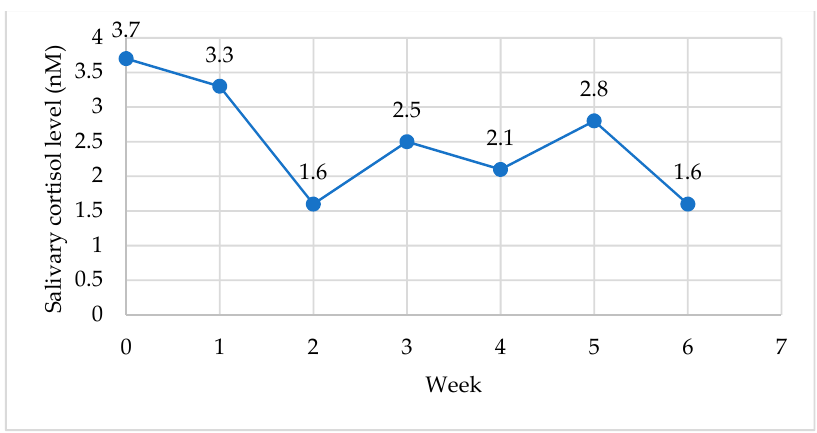
Figure 4. Resting salivary cortisol levels from baseline to week six of the program ( n = 17). Paired-Sample t -Tests Pre- and Post-Program A Shapiro–Wilk test showed the probability of normality for the CAR (waking) dataset, W (17)= 0.93, p = 0.30, and resting dataset, W(17) = 0.97, p = 0.91; therefore, normality was assumed ( p > 0.05). Paired sample t -tests were completed to compare the measure scores pre- (week 0) and post-program (week 6) and pre- and post-session for weeks 4 to 6. A summary of the paired sample t -test analysis is provided in Table 6. Table 6. Paired sample t -test results summary for Time One (pre-program or pre-session) and Time Two (post-program or post-session)